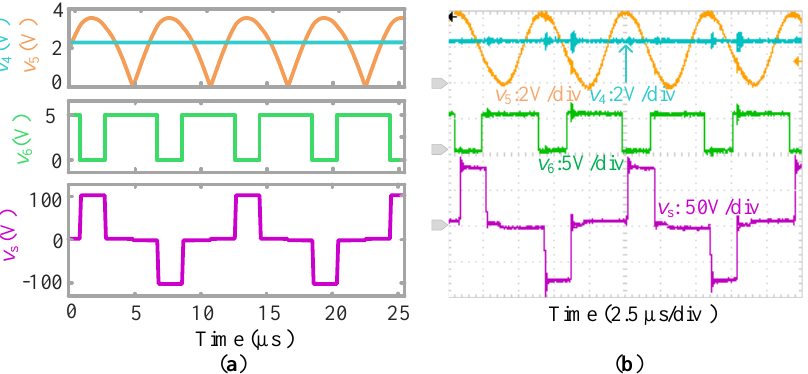
Figure 14. Logical waveforms of APC receiver: ( a ) simulated; and ( b ) experimental. v 4 , feedback signal (blue lines); v 5 , half-wave signal (yellow lines); v 6 , control signal (green lines); v s , secondary resonant voltage (purple lines).